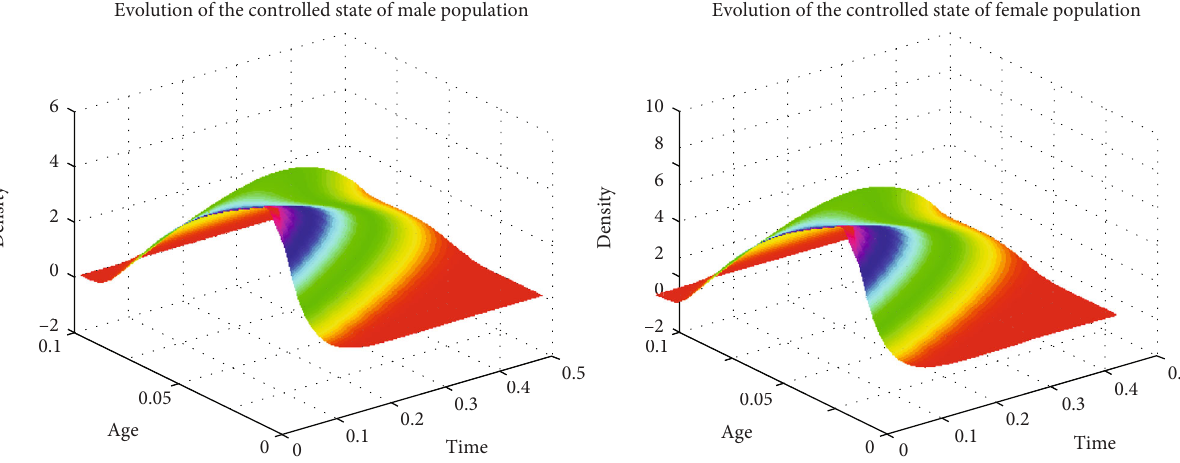
Figure 5: Evolution of the controlled system from a = t = 0 to A = 2 and t = 0 : 5 .